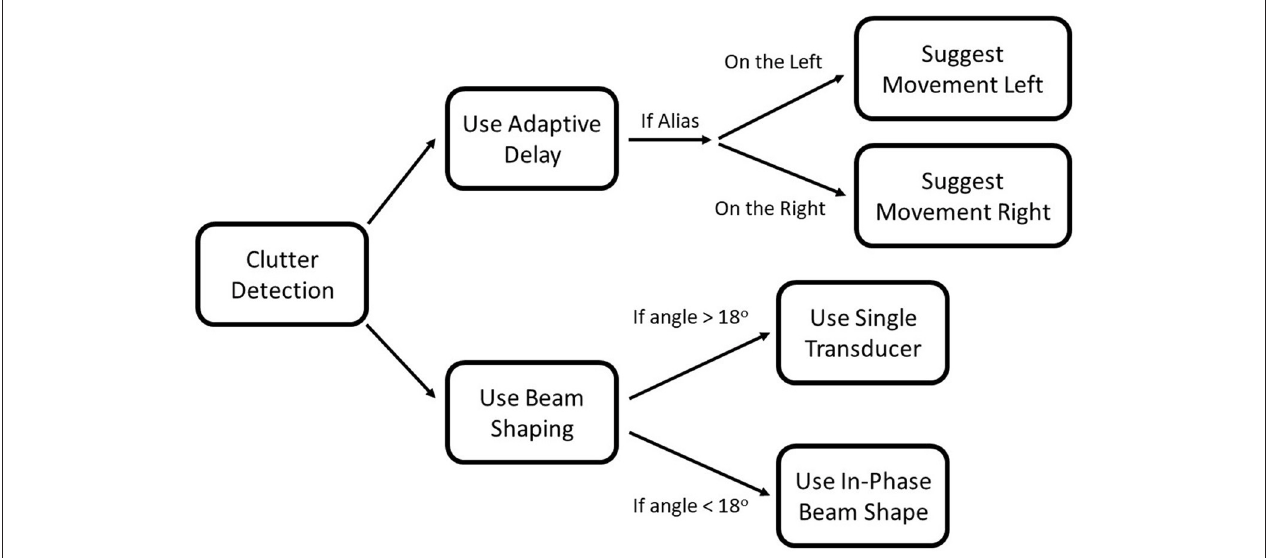
FIGURE 15 | Flowchart for integrating the three strategies. Once clutter is detected, beam shaping, and the adaptive delay can be used simultaneously. If the adaptive delay determines that the object is an alias, a movement direction will be suggested.